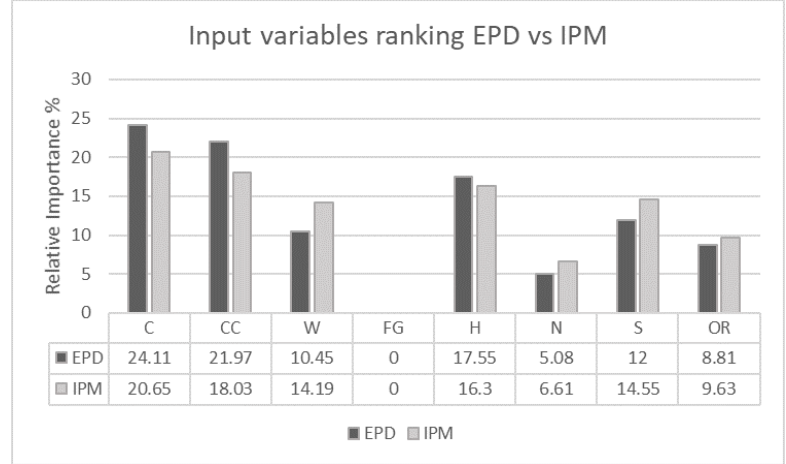
Figure 11. Relative importance in % to the joint response (demand and price of electricity) of energy generation variables using the VIT Euclidean probabilistic distance (EPD) and Intervention prediction measure